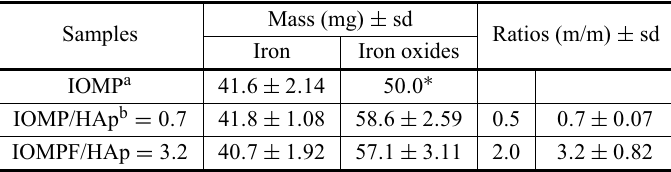
Flame atomic absorption spectrometry results from uncoated and coated iron oxide magnetic particles.